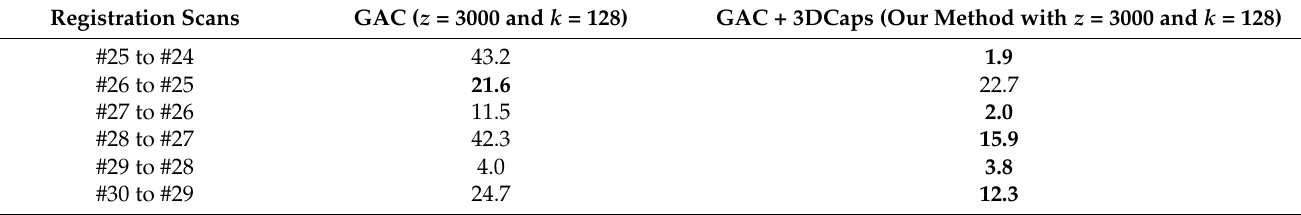
Table 9. The RRE ( ◦ ) of registration results of GAC and GAC+ 3DCaps (our method) in the last six pairs of scans of Dataset II. Registration Scans GAC ( z = 3000 and k =